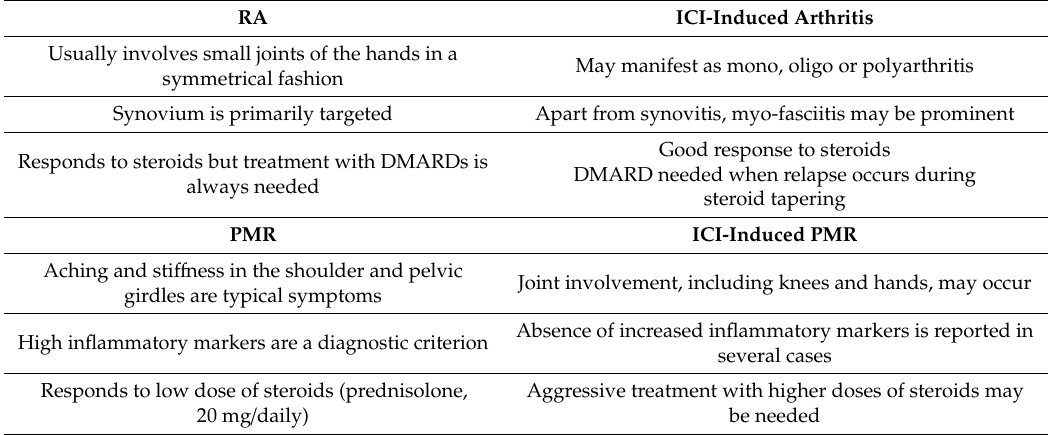
Table 1. Main di ff erences between ICI-induced rheumatic syndromes and their idiopathic counterparts. RA ICI-Induced